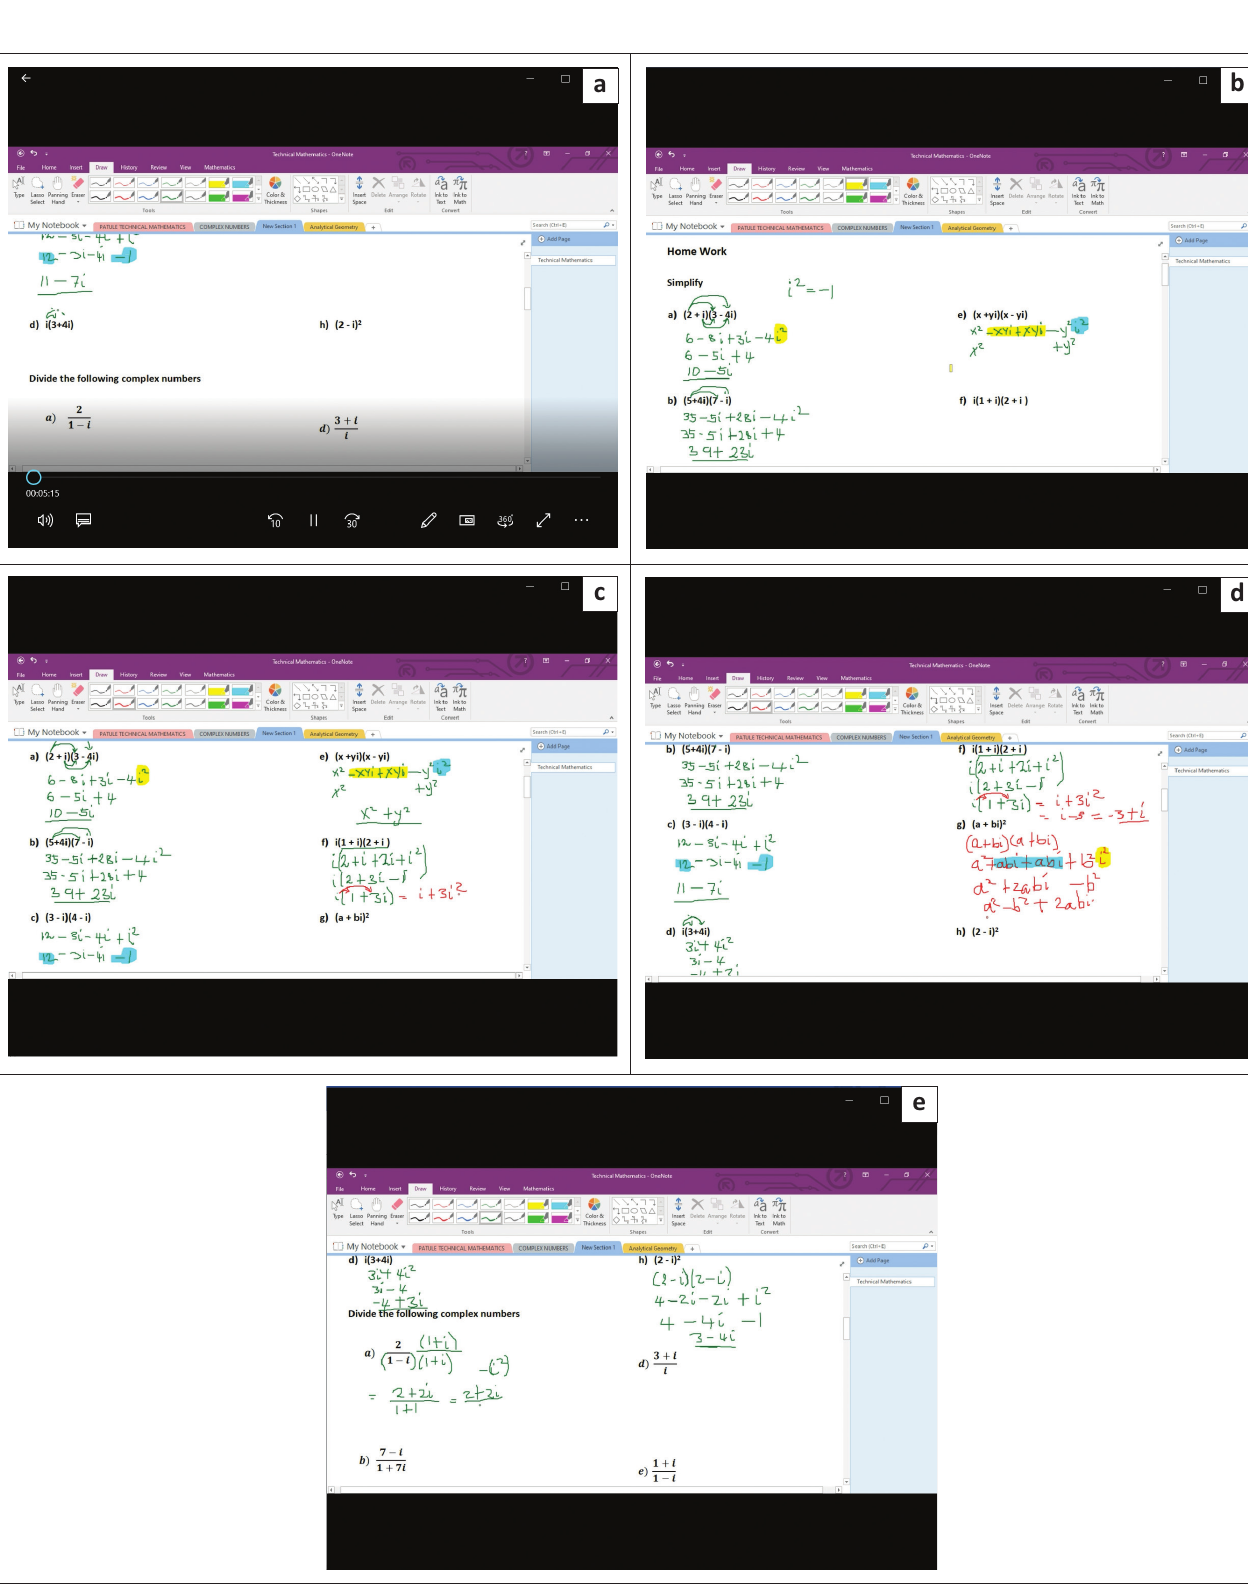
FIGURE 3: Example of observed lessons presented through Microsoft OneNote and Zoom, (a) Lesson 1, (b) Lesson 2, (c) Lesson 3, (d) Lesson 4, (e) Lesson